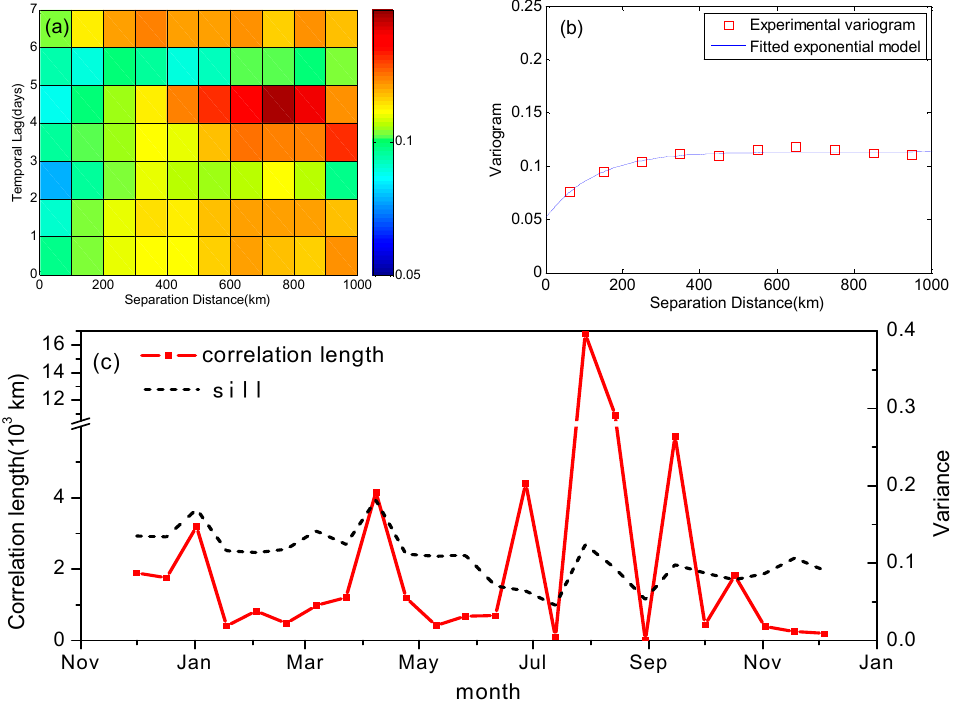
Figure 3. ( a ) The spatial and temporal variograms of FMF over a 16-day period from 18 January to 2 February 2015 for MODIS. The color bar indicates the semivariance; ( b ) The spatial variogram over the same period from MODIS; ( c ) Correlation length, variance of FMF for all 16-day periods from